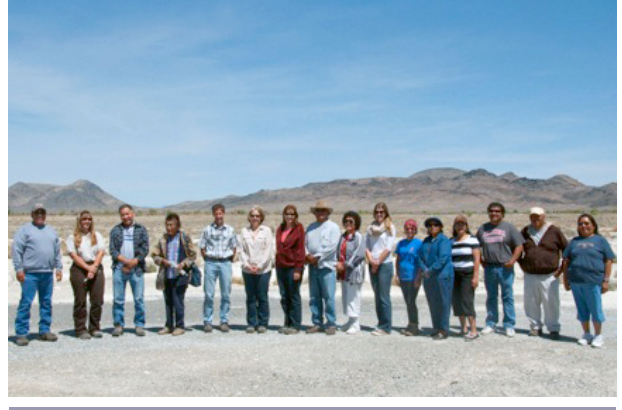
Fig. 6 . Newe (Western Shoshone), Nuwuvi (Southern Paiute), U.S. Fish and Wildlife Service, and Portland State University/ The Mountain Institute participants in collaborative research at Ash Meadows National Wildlife Refuge (part of the Desert National Wildlife Refuge Complex), Nevada. April 2012. Photo: Jeremy